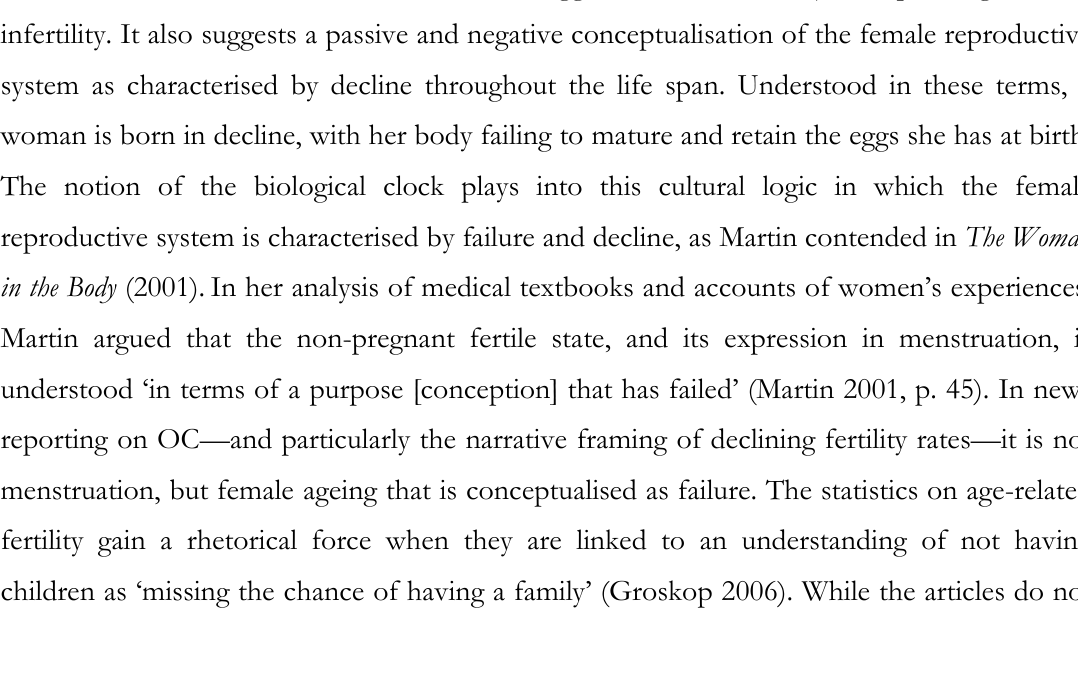
Lucy van de Wiel, For Whom The Clock Ticks: Reproductive Ageing and Egg Freezing in Dutch and British News Media Studies in the Maternal , 6(1), 2014,